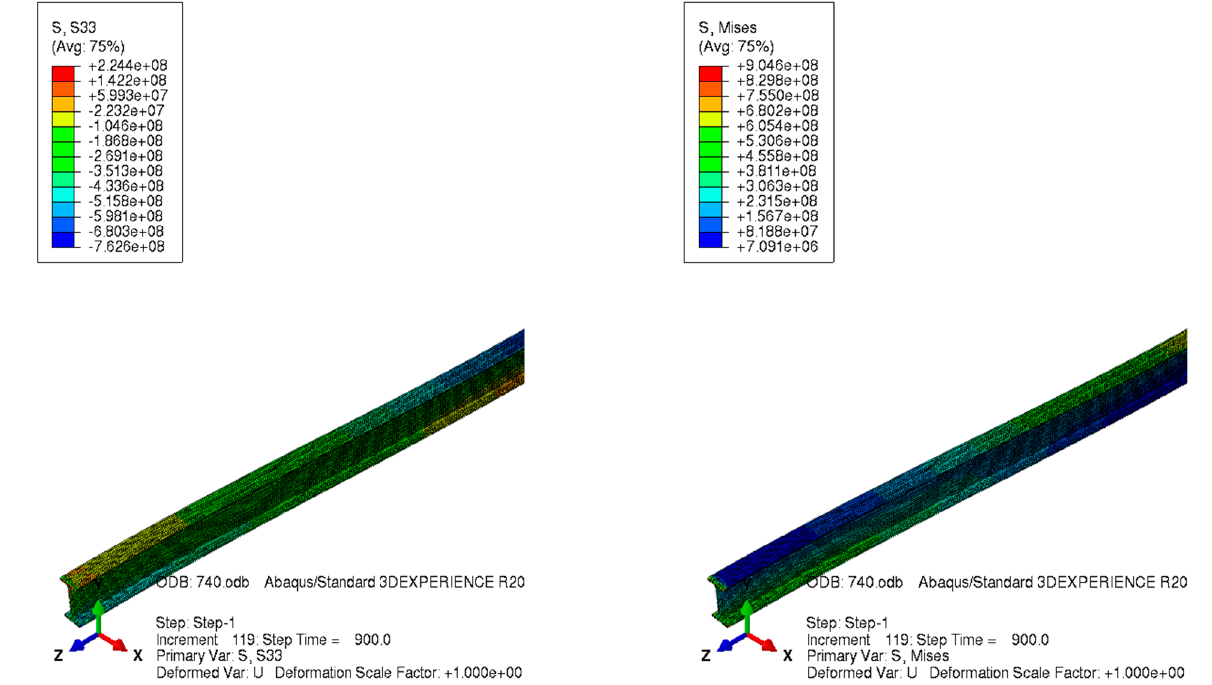
Figure 9. Normal stress S33 (left) and the reduced stress (right) distributions at t = 900 s.